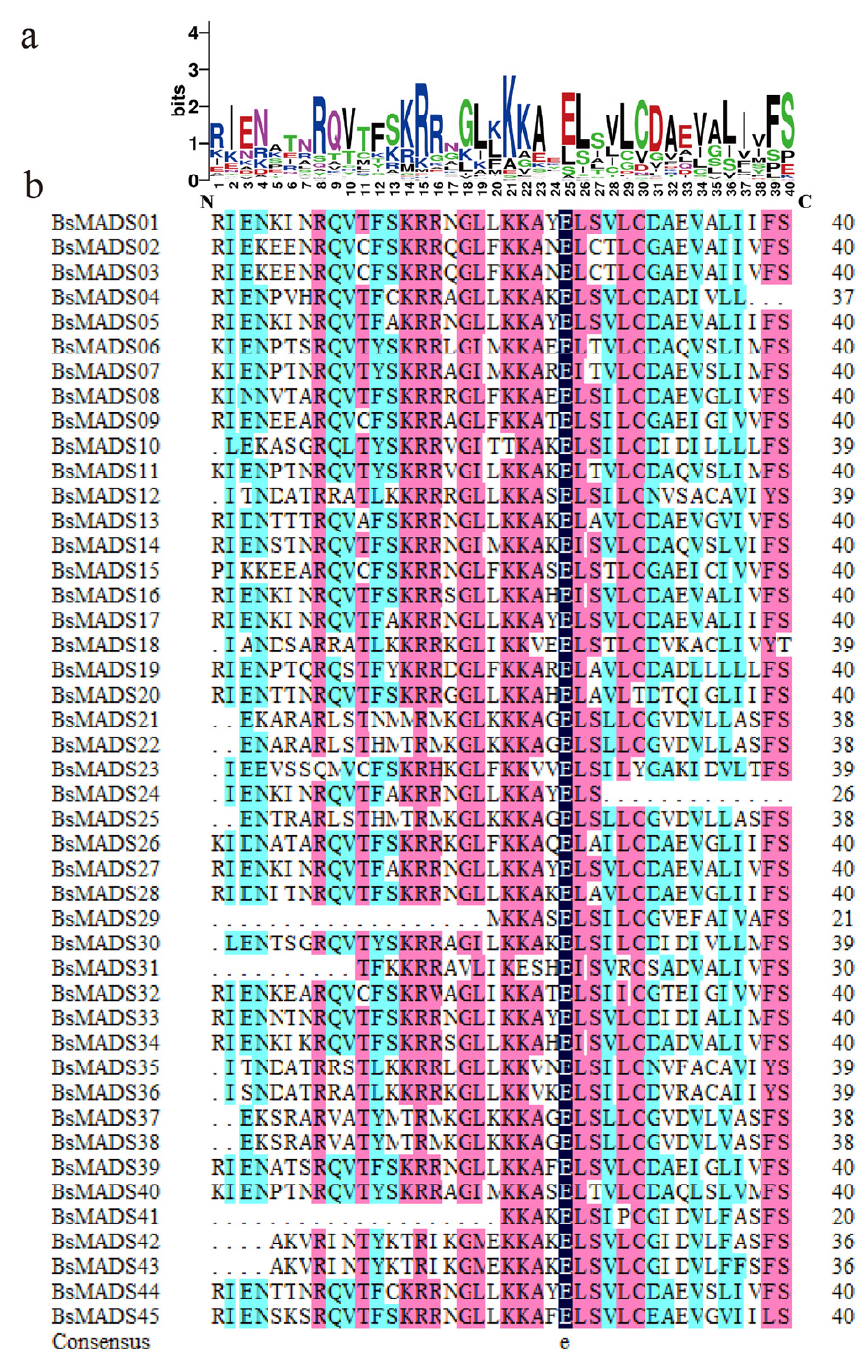
Figure 1. Sequence logo and multiple alignment analysis of the SRF-TF domain: ( a ) sequence logo of the SRF-TF domain. ( b ) Multiple alignment analysis of the SRF-TF domain. The different colors of shading indicate the same and conserved amino acid residues, respectively.